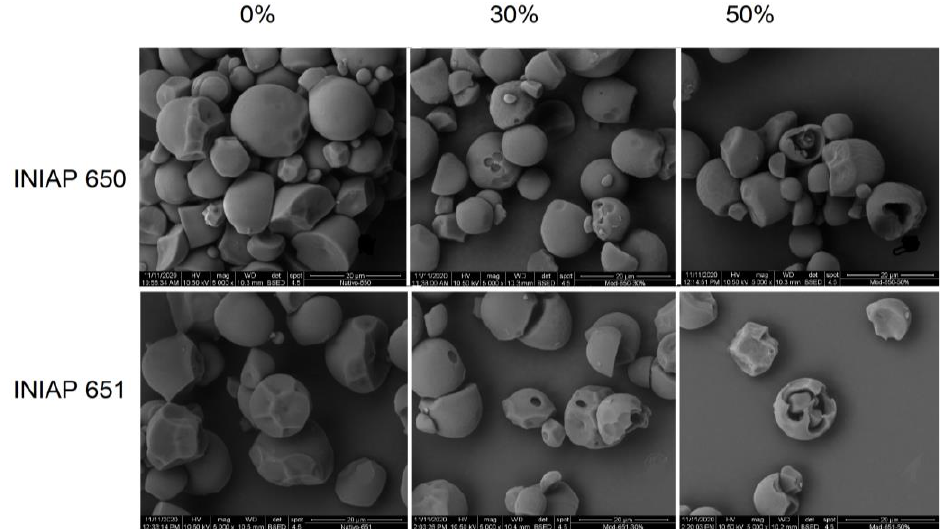
Figure 1. Scanning electron micrograph of two cassava starch varieties (INIAP-650 and INIAP-651) hydrolyzed at 0%, 30%, and 50%. Magnification 5000 ×